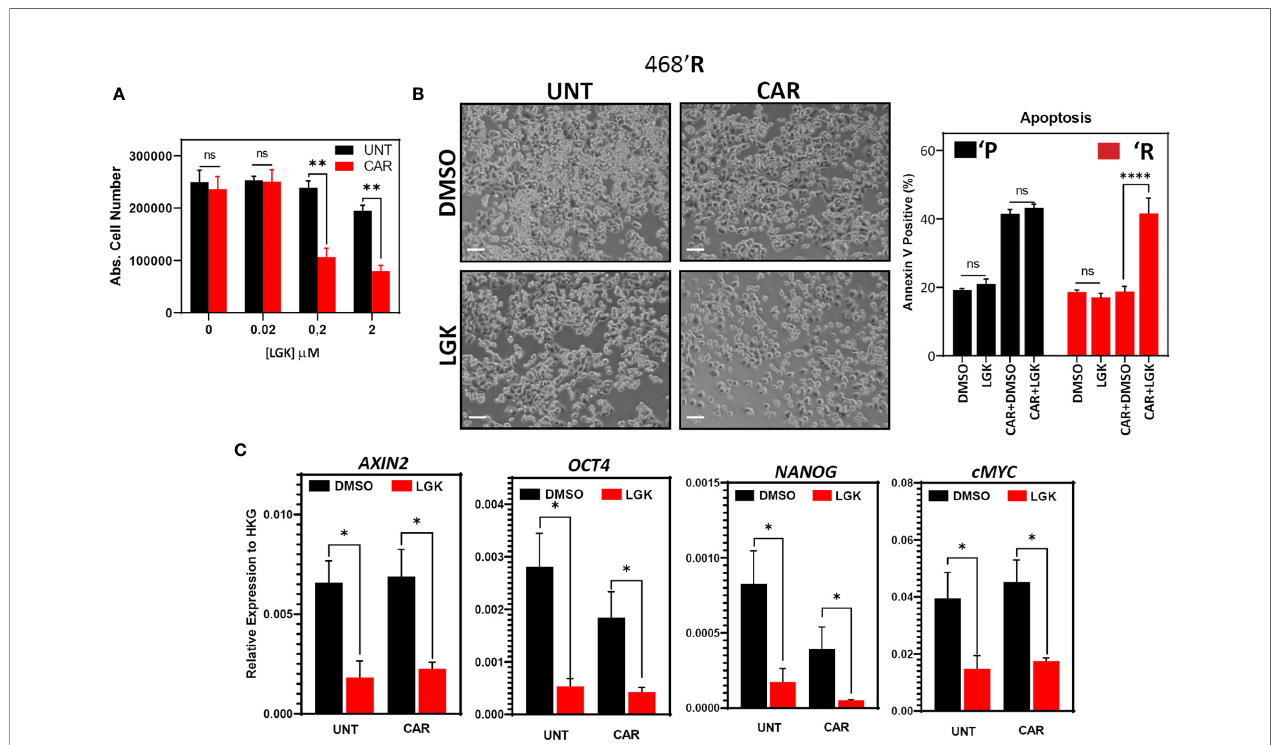
FIGURE 4 | Wnt inhibitor LGK974 disrupts carboplatin resistance and pluripotency gene expression. (A) Absolute cell number of 468 ’ R cells treated for 72 hours with increasing concentrations of LGK974 in the presence or absence of 2 m M carboplatin. Multiple t-tests (n=3). (B) Phase-contrast microscopy of 468 ’ R cells treated for 72 hours with 200 nM LGK974 or DMSO in the presence or absence of 2 m M carboplatin (left). Mean frequency of annexin V positive cells in 468 ’ P and 468 ’ R cells treated with or without 200 nM LGK974 in presence or absence of 2 m M carboplatin showing the resensitization of 468 ’ R cells to carboplatin when co- treated with Wnt inhibitor (right, n=3). One-way Anova with correction for multiple comparisons using the Holm-Sidak method. (C) Relative mRNA expression of Wnt target and stem cell markers upon 72-hour treatment with DMSO or 200 nM LGK974 with or without 2 m M carboplatin in 468 ’ R cells (n=3). Multiple t-tests: Unt vs . Unt+LGK & CAR vs . CAR+LGK. (Barplots represent mean + SEM. * p < 0.05; **p < 0.01; ****p < 0.0001 ; ns, non signi fi